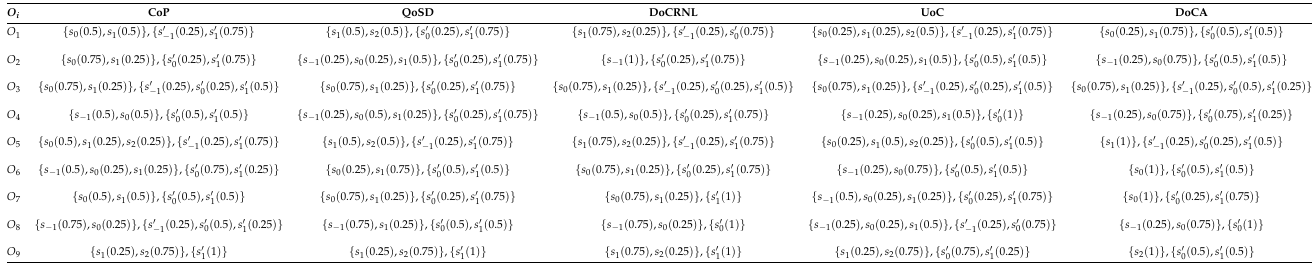
Table 9. The Γ matrix before